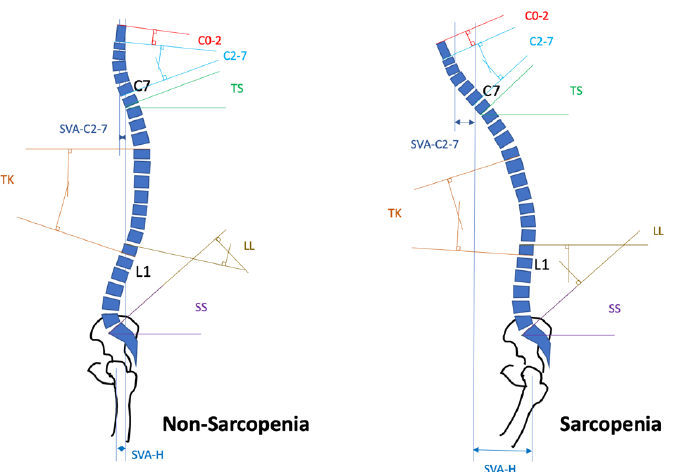
Figure 1. Schematic images comparing the postures of patients with a spinopelvic mismatch in spinal sarcopenia and non-spinal sarcopenia groups. Cervical parameters include C2-7L, cSVA, T1S, and C0-2. Lower extremity parameters include TK, LL, SS, and SVA-Hip. C2–C7L: C2–C7 Cobb angle; cSVA: